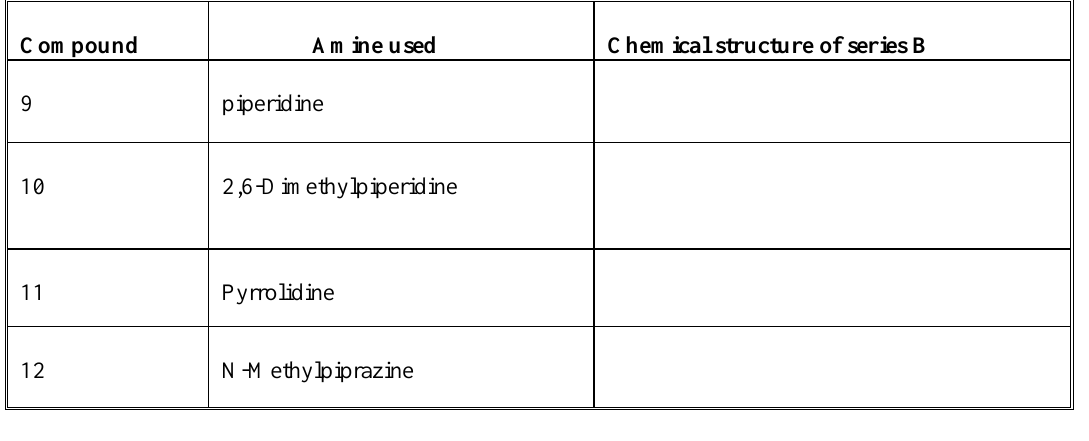
Table (2): Synthesis of series B compounds